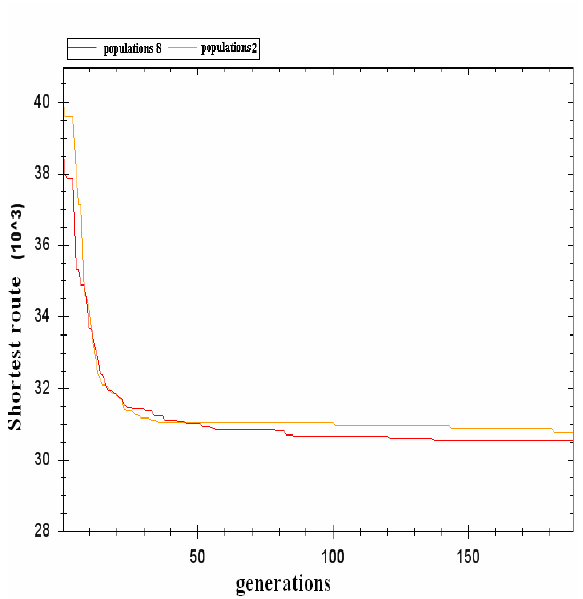
Figure10. The average result 2 of TSP benchmark instances Chn144 by different number of